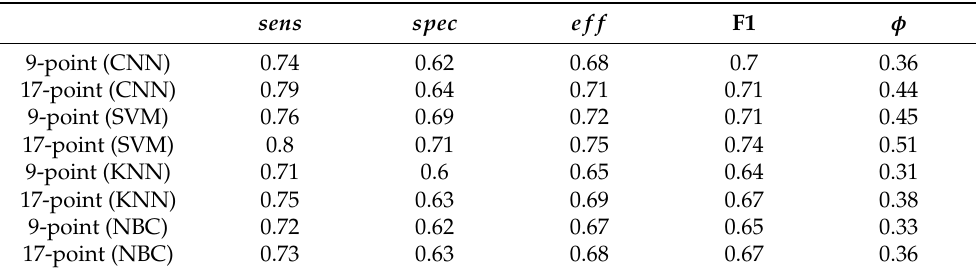
Table 5. Results of binary classification of model data only using 9-point and 17-point schemes for measuring brightness temperature and infrared temperature. sens spec ef